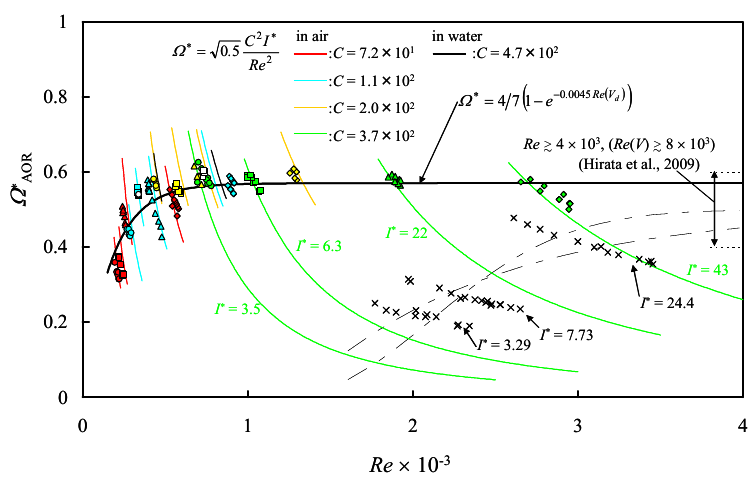
Fig. 5 Reduced rotating rate Ω * AOR averaged over one rotation versus Reynolds number Re , for λ = 0.3, AR = 10, C = 7.2 × 10 1 − 4.7 × 10 2 and I * = 0.75 −